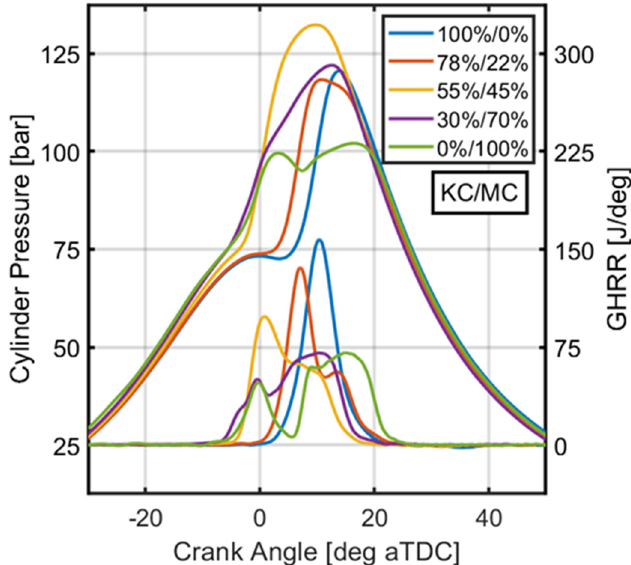
Figure 10. Cylinder pressure and gross heat release rate (GHRR) of a mixing-controlled fraction sweep. The legend indicates the fuel energy split between kinetically-controlled (KC) and mixing-controlled (MC) injections.